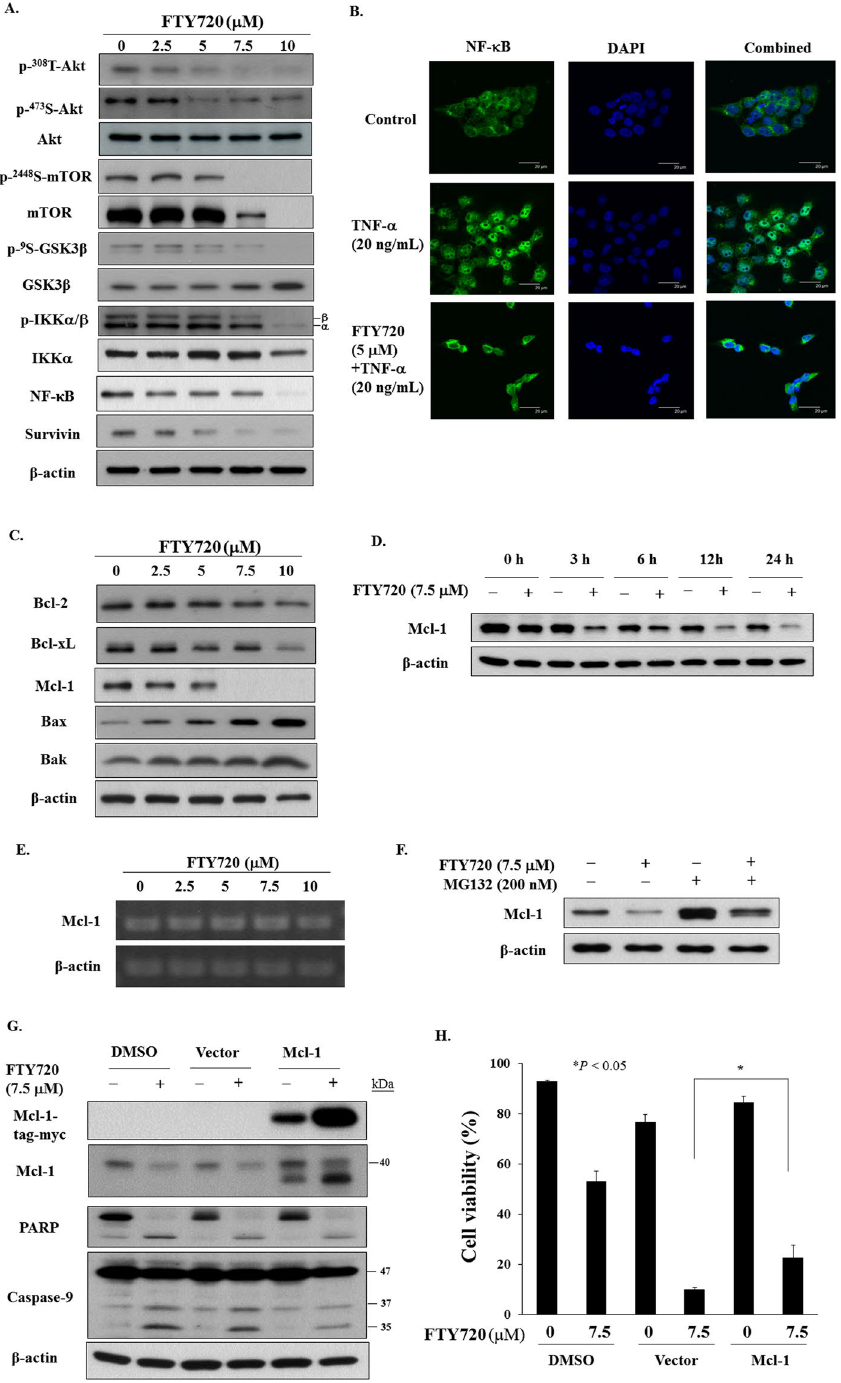
Figure 2. ( A ) Dose-dependent effects of FTY720 on the phosphorylation of Akt, mTOR, GSK3 β , and IKK α / β , and the expression of NF- κ B, and survivin in SCC2095 cells. Cells were treated with FTY720 in 5% FBS-supplemented DMEM/F12 medium for 24 h, and cell lysates were immunoblotted as described in Material and Methods. ( B ) Effect of FTY720 on the nuclear translocation of NF- κ B. SCC2095 cells were treated with 5 μ M FTY720 for 24 h, stained with anti-NF- κ B, and examined by confocal microscopy. ( C ) Dose-dependent effects of FTY720 on the expression of Bcl-2, Bcl-xL, Mcl-1, Bax, and Bak. ( D ) Time-dependent effects of FTY720 on the expression of Mcl-1. ( E ) Mcl-1 mRNA expression measured by RT-PCR in cells treated with FTY720. ( F ) Effect of proteasome inhibitor on Mcl-1 expression. Cells were exposed to FTY720 in the presence or absence of 200 nM MG132 for 24 h. ( G ) Effect of ectopic Mcl-1 expression on apoptotic related proteins. SCC2095 cells were transfected with control vector or Mcl-1 plasmid for 24 h and then exposed to FTY720 for 24 h. Whole cell extracts were subjected to Western blot analysis. ( H ) Effect of Mcl-1 overexpression on the viability of SCC2095 treated with FTY720 (7.5 μ M) for 24 h. After incubation, cells were analyzed using flow cytometry. Columns , means; bar , S.D. * P <